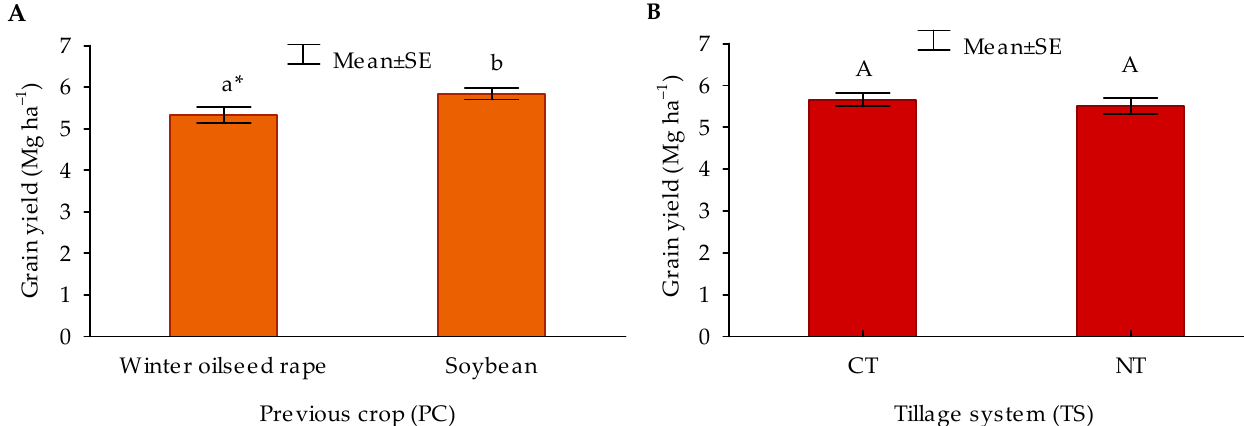
Figure 1. Winter wheat grain yield depending on previous crop ( A ) and tillage system ( B ) (mean for 2014–2017). CT— Conventional tillage; NT—No-tillage. * Different letters denote significant differences ( p ≤ 0.05). The same letter means not significantly different values. The lowercase letters refer to previous crops (PC); the capital letters refer to tillage systems